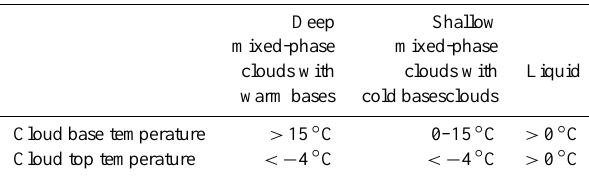
Table 2. Definitions of warm and cold base mixed-phase clouds and liquid clouds in this study.